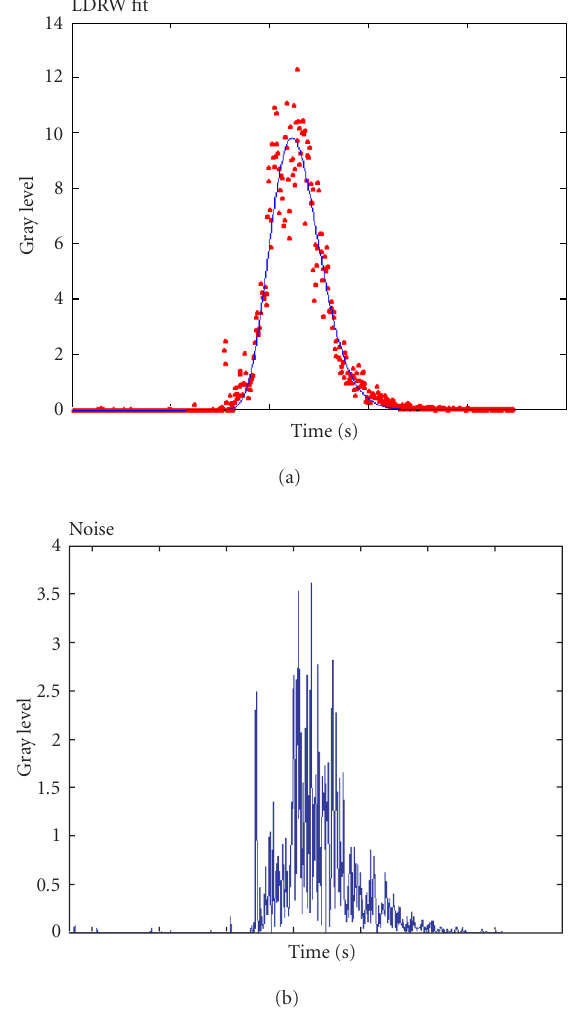
Figure 7: A measured IDC with fitted LDRW model (a) and the absolute value of the di ff erence between the model and the experi- mental data (b). The noise is clearly correlated to the signal ampli-